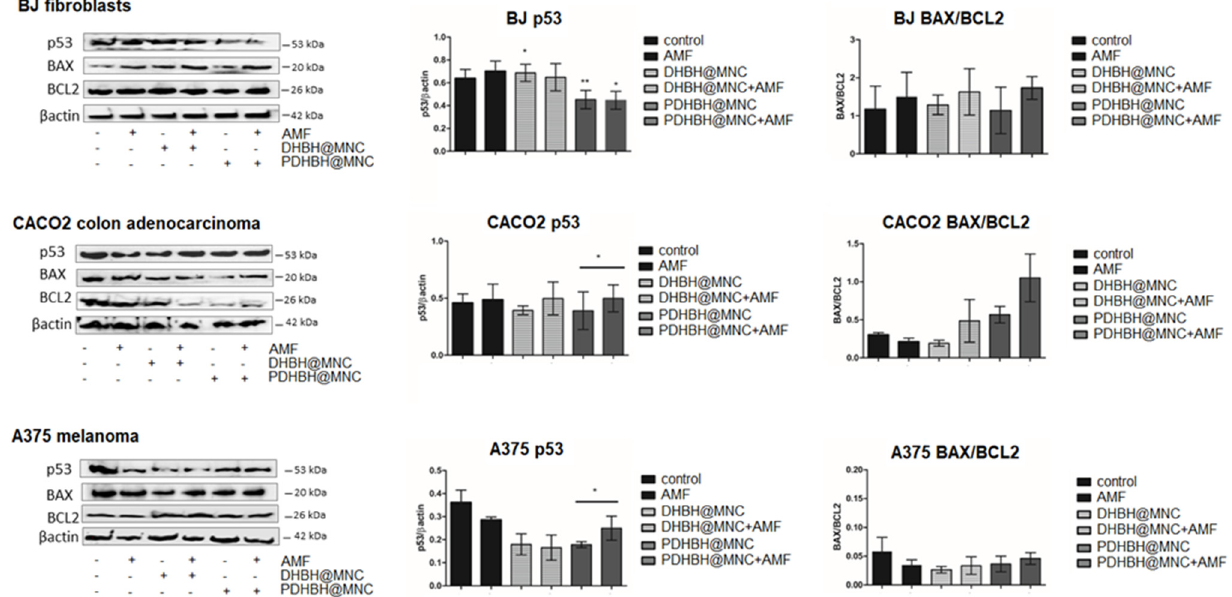
Figure 12. Western blot analysis of the protein expressions of the p53 apoptosis pathway of cells (fibroblasts (BJ), upper panels; colon adenocarcinoma (CACO2), middle panel; and melanoma (A375), lower panel). Image analysis of WB bands was undertaken by densitometry, results were normalized to β actin; BAX/BCL2 ratio is presented. Each bar represents mean ± standard deviation (n = 3); * = p < 0.05, ** = p < 0.001, control versus treated group (cells exposed to AMF, incubated with MNC with and without MH exposure) for each cell line.